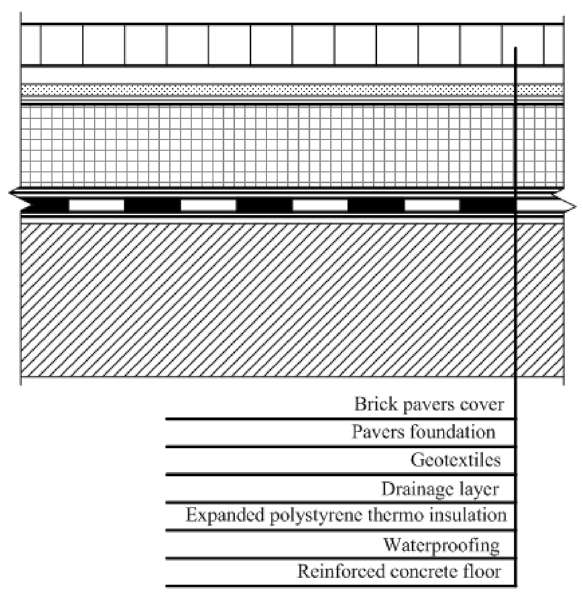
Fig. 2. Installation option of the reverse exploitable roof Installation Options of Exploitable Roofing .